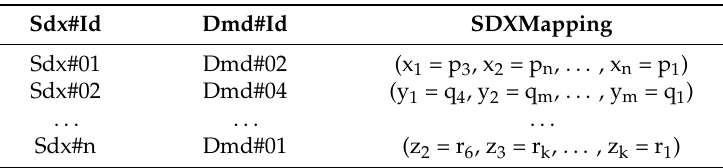
Table 6. SDX Mapping between DMD and MCAttributes.